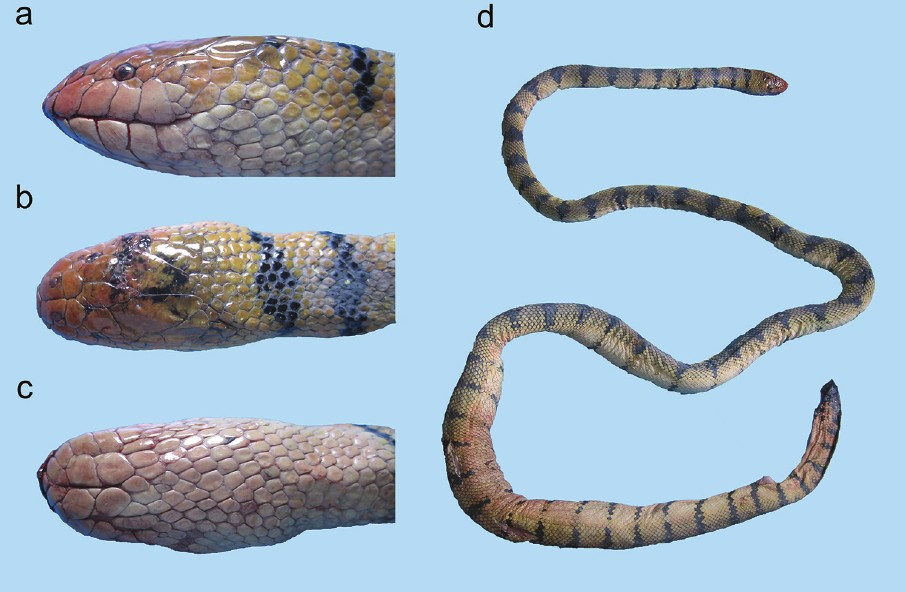
Figure 15. Hydrophis spiralis : a lateral view b dorsal view, and c ventral view of head d body. 67, GBD 90, NSL 7, NSR 30, BSR 38, NV 387, NB 61], December 2013, collector: M.